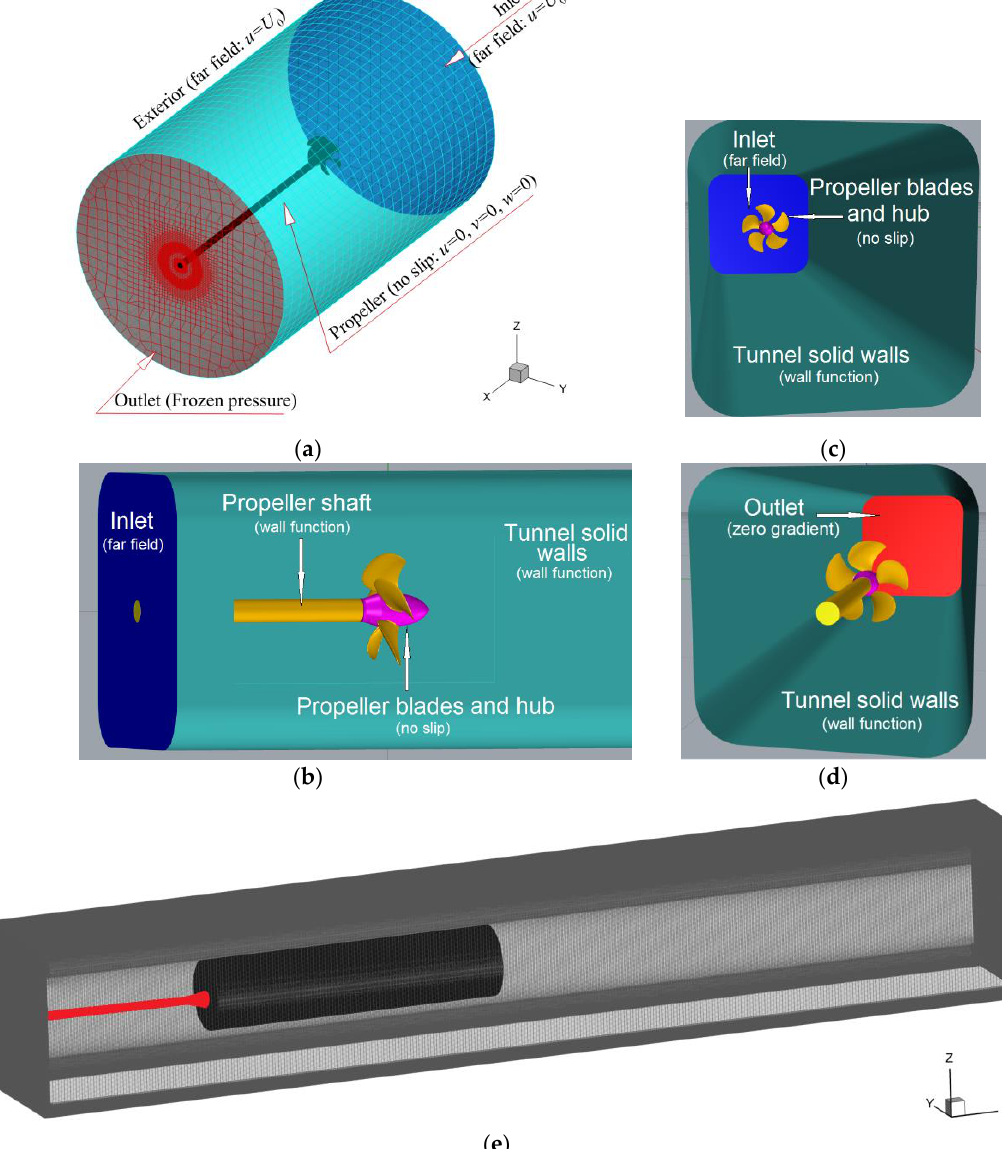
Figure 1. Computational domain and boundary conditions formulation. ( a ): non-cavitation computations; ( b ): side view of the computational domain for the cavitation computation; ( c ): computational domain for the cavitation computation—view from outlet; ( d ): same as previous—view from inlet; ( e ): side view of the cavitation tunnel grid.